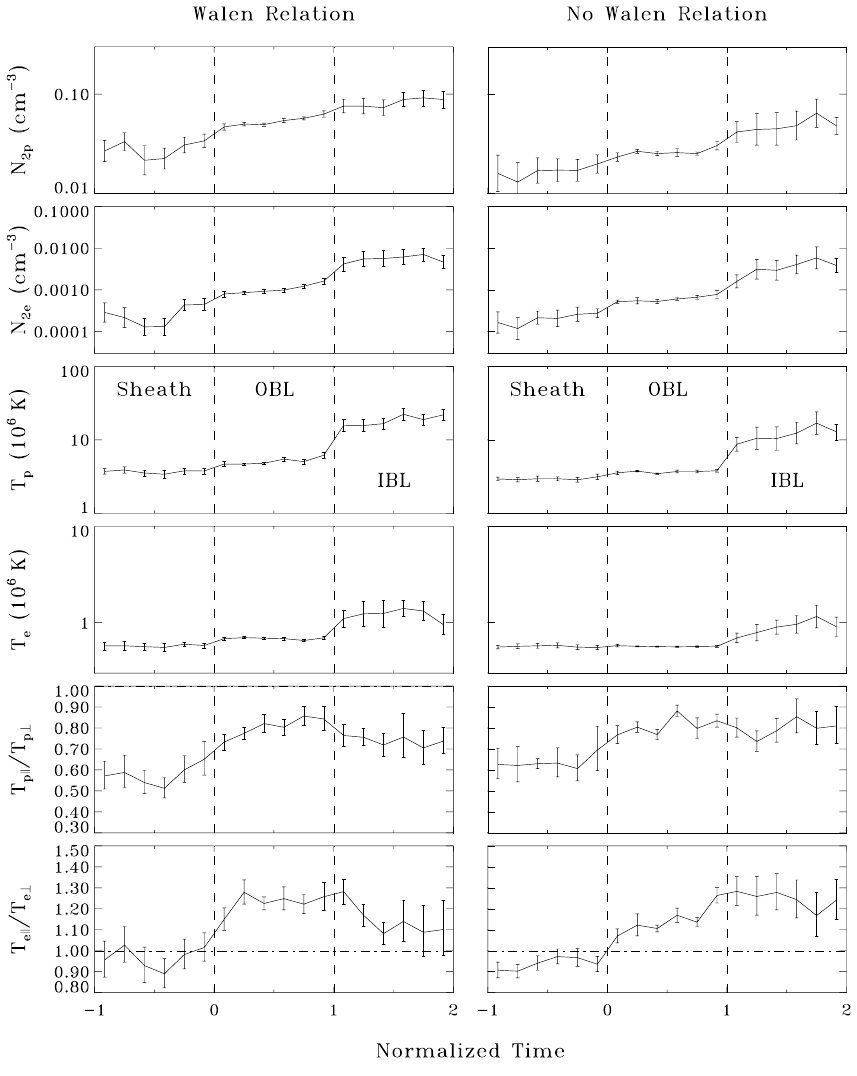
Fig. 5. Superposed epoch analysis of the partial density, N 2 p , of protons above 8keV, the partial density, N 2 e , of electrons above 1.8keV, the proton tem- perature, T p , the electron temperature, T e , the proton temperature anisotropy, T p /T p ⊥ , and the electron temperature k /T e ⊥ , across the outer anisotropy, T e k boundary layer. The format is the same as in Fig.